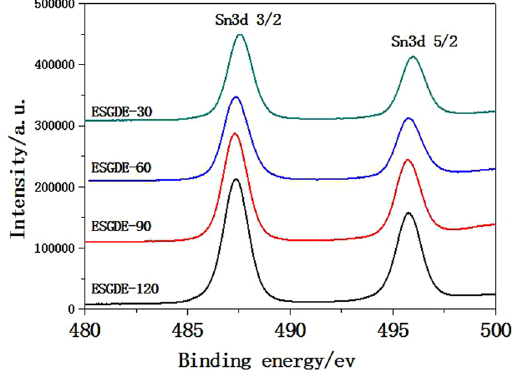
Figure 4. XPS spectrum of Sn3d in the ESGDEs with different electrodeposition